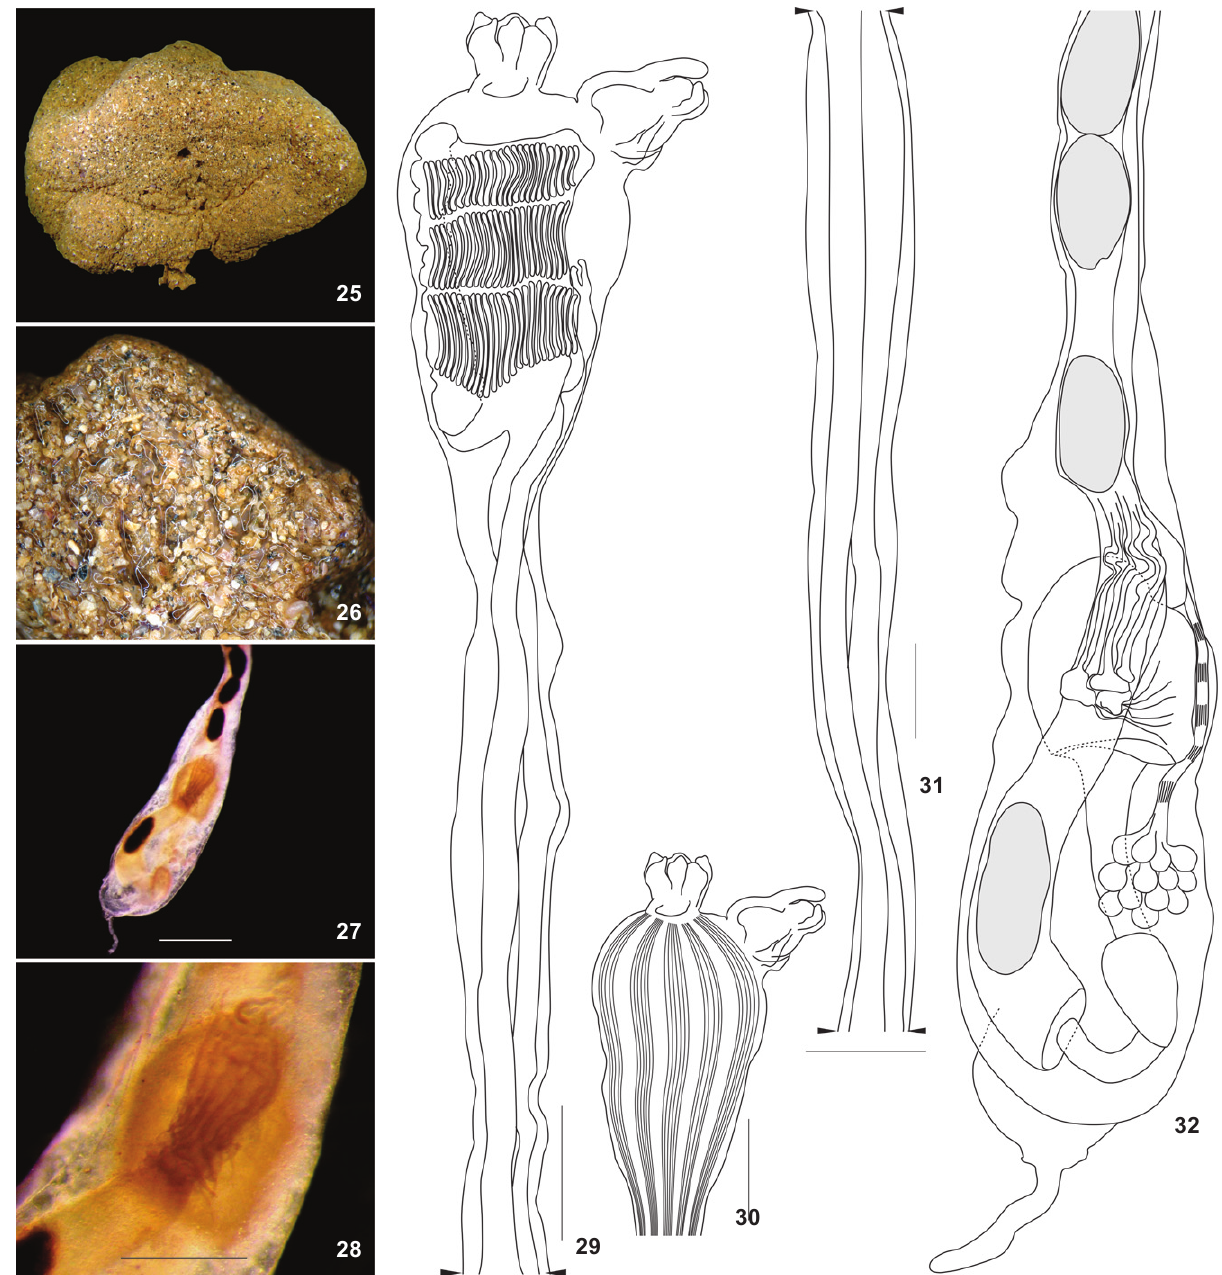
Figures 25-32. Eudistoma sp. 1: (25) colony fixed in formalin; (26) colony cross-section. (27) final portion of the abdomen; (28) abdo- men in detail, showing the pyloric tubules; (29) thorax and anterior abdomen; (30) musculature pattern on the thorax; (31) the middle portion of the abdomen; (32) posterior portion of the abdomen. Scale bars: 27 = 1.0 mm; 28-32 = 0.5 mm.